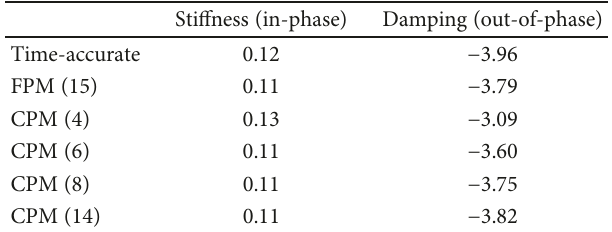
Table 2: Dynamic derivatives for NACA 0012 airfoil from pitching